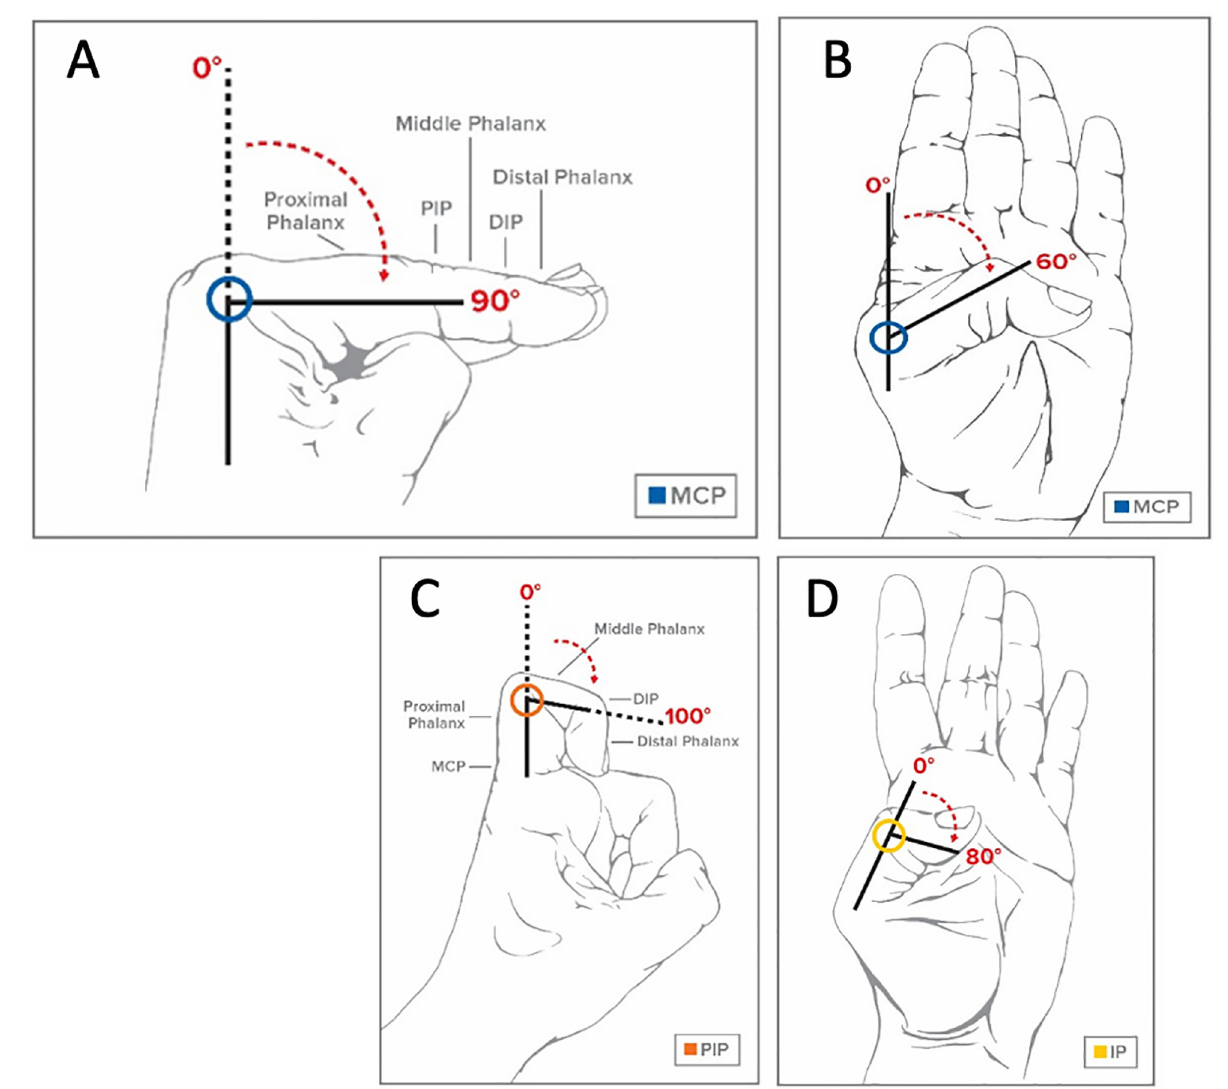
Fig 6. Measured angles. Measured position for the metacarpophalangeal (MCP) joint of the index finger (A), and of the thumb (B). Measured angles of the proximal interphalangeal (PIP) joint of the index finger (C), and of the thumb (D).